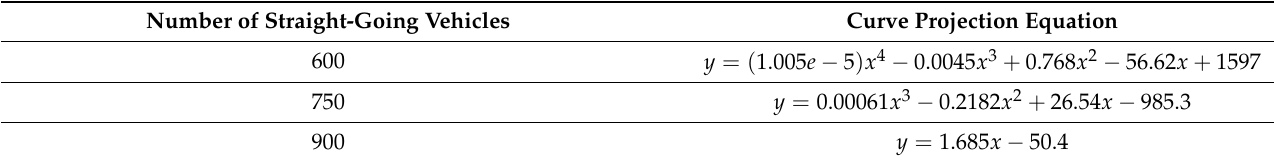
Figure 2. The influence of different numbers of left-turn vehicles and lengths of the weaving section on the delay. ( a ) The number of straight-going vehicles is 600 veh/h. ( b ) The number of straight-going vehicles is 750 veh/h. ( c ) The number of straight-going vehicles is 900 veh/h. ( d ) The number of straight-going vehicles is 1050 veh/h. It can be seen from Figure 2 that when the number of straight-going vehicles is con- stant, the delay changing law of inside or outside left-turn lanes has certain similarities. Table 2. The critical equation under different numbers of straight-going